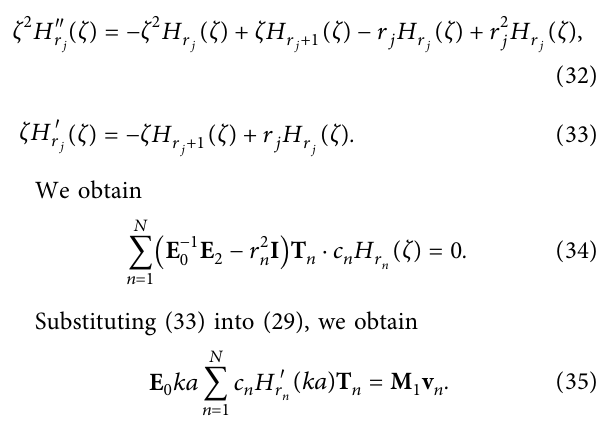
1 versus σ 0 for different values of H with